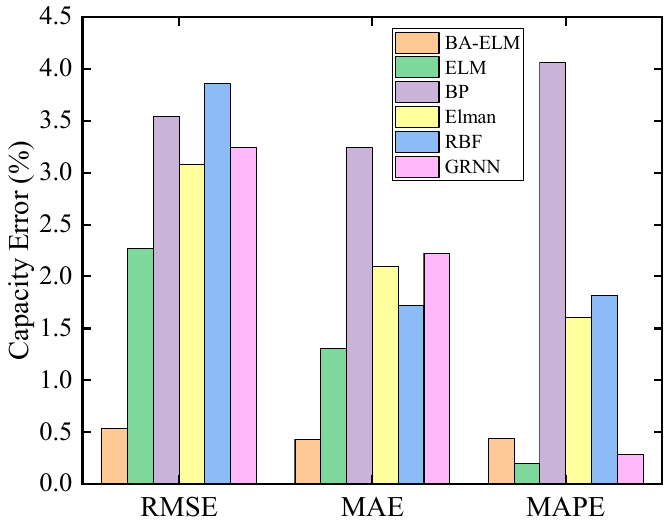
Figure 18. Comparison of RMSE MAE and MAPE.